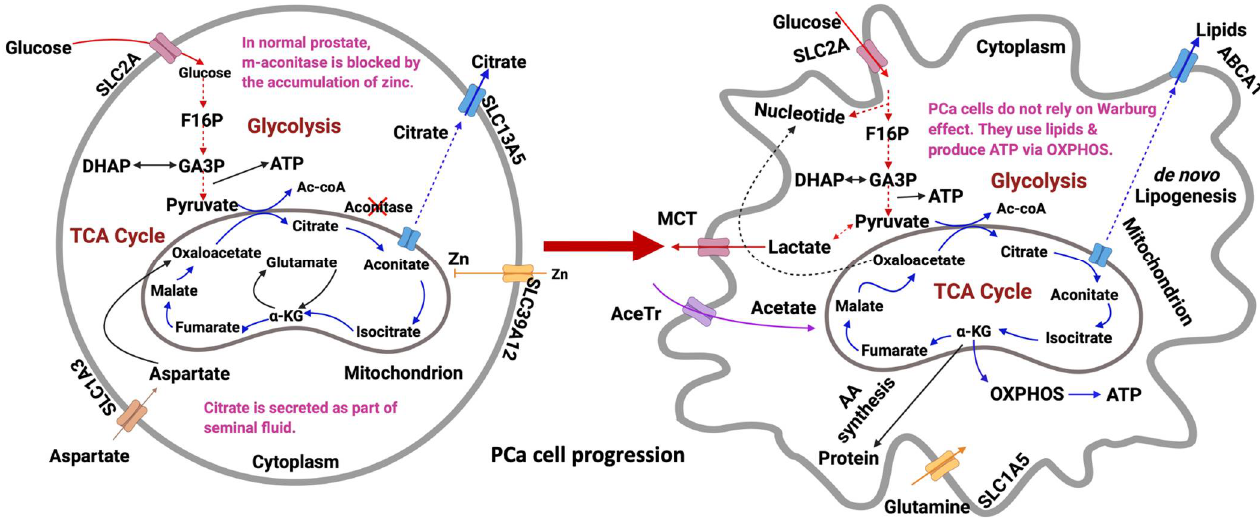
Figure 3. Metabolic profile of epithelial prostate cell during tumorigenesis. In the normal type ( left ), zinc inactivates m-aconitase (ACO), which accumulates citrate to prostatic fluid. In the malignant type, cells do not rely on the Warburg effect; although, they produce lactate. Instead, they consume lipids (generated via de novo lipogenesis), activate the TCA cycle, and stimulate OXPHOS for ATP generation. Enhanced glutamine metabolism and acetate consumption were also observed in PCa cells. Dashed lines indicate abridged pathways, and solid lines indicate direct pathways. Transporters for each species are indicated. Figure drawn using BioRender [26].